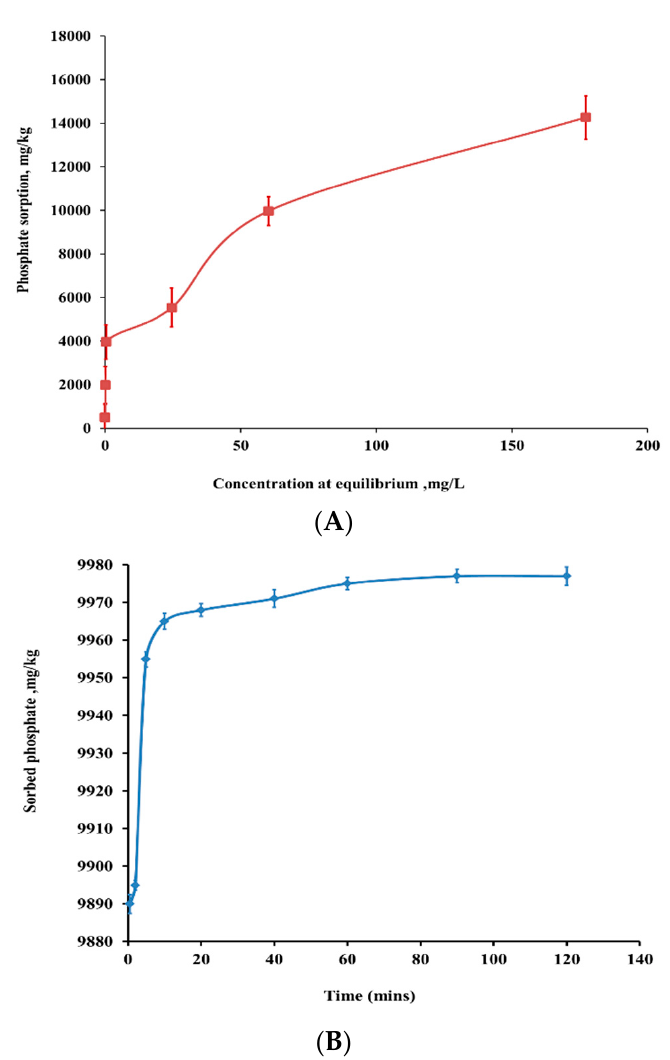
Figure 2. ( A ): Phosphate sorption isotherm of nSD-KF bio-sorbent, ( B ): effect of contact time on PO4 − 3 sorption by nSD-KF at initial PO4 − 3 concentration of 160 mg/L at temperature of 298 K.